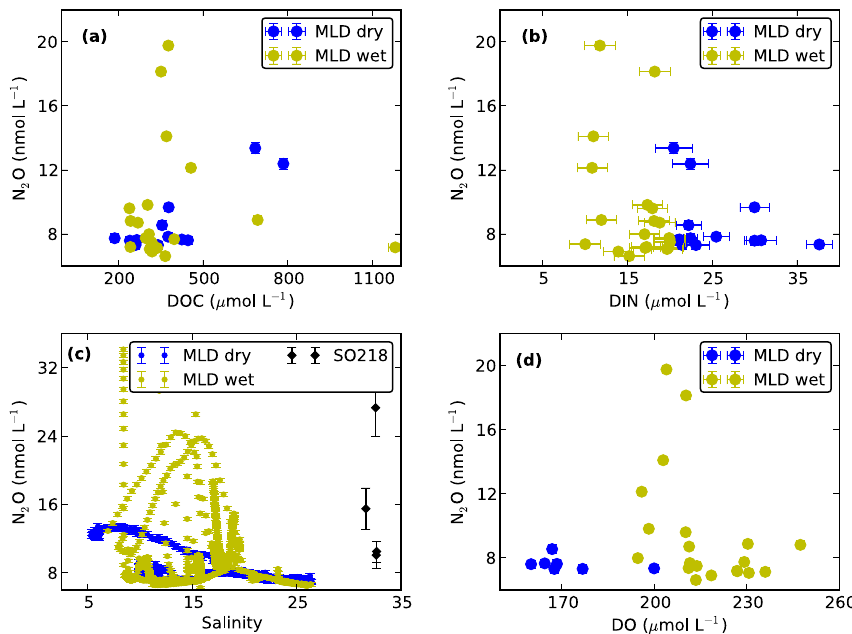
Figure 2. Relationship of nitrous oxide concentrations with (a) dissolved organic carbon (DOC), (b) dissolved inorganic nitrogen (DIN), (c) salinity, and (d) dissolved oxygen (DO). MLD refers to the campaigns on the Lupar and Saribas estuaries in the dry and wet season, respectively; SO218 denotes data from the R/V Sonne